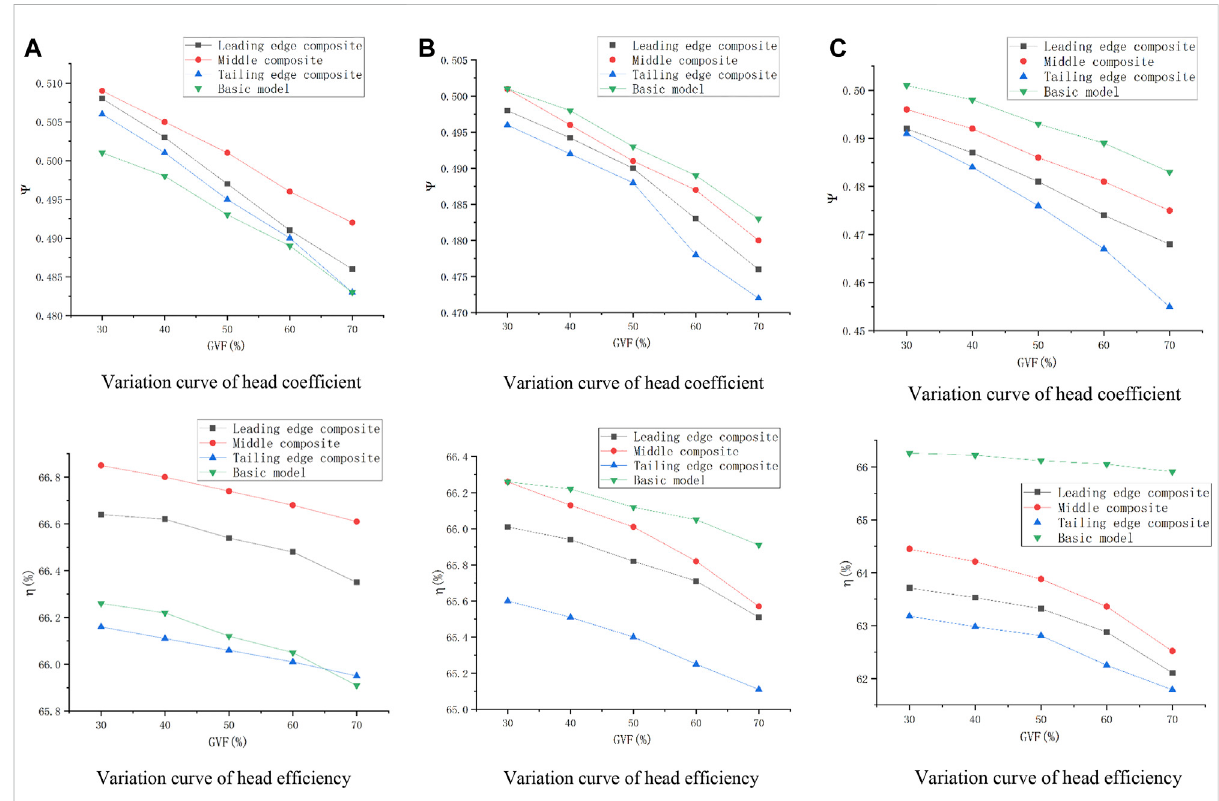
FIGURE 6 Head coef fi cient and ef fi ciency of different schemes. (A) Scheme 1 Changes in the external characteristics of the multiphase pump with a maximum thickness of 1mm. (B) Scheme 2 Changes in the external characteristics of the multiphase pump with a maximum thickness of 2mm. (C) Scheme 3 Changes in the external characteristics of the multiphase pump with a maximum thickness of 3